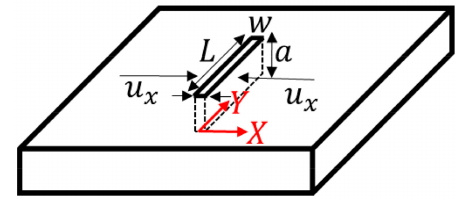
Figure 2. Schematic of slit introduced by FIB milling.